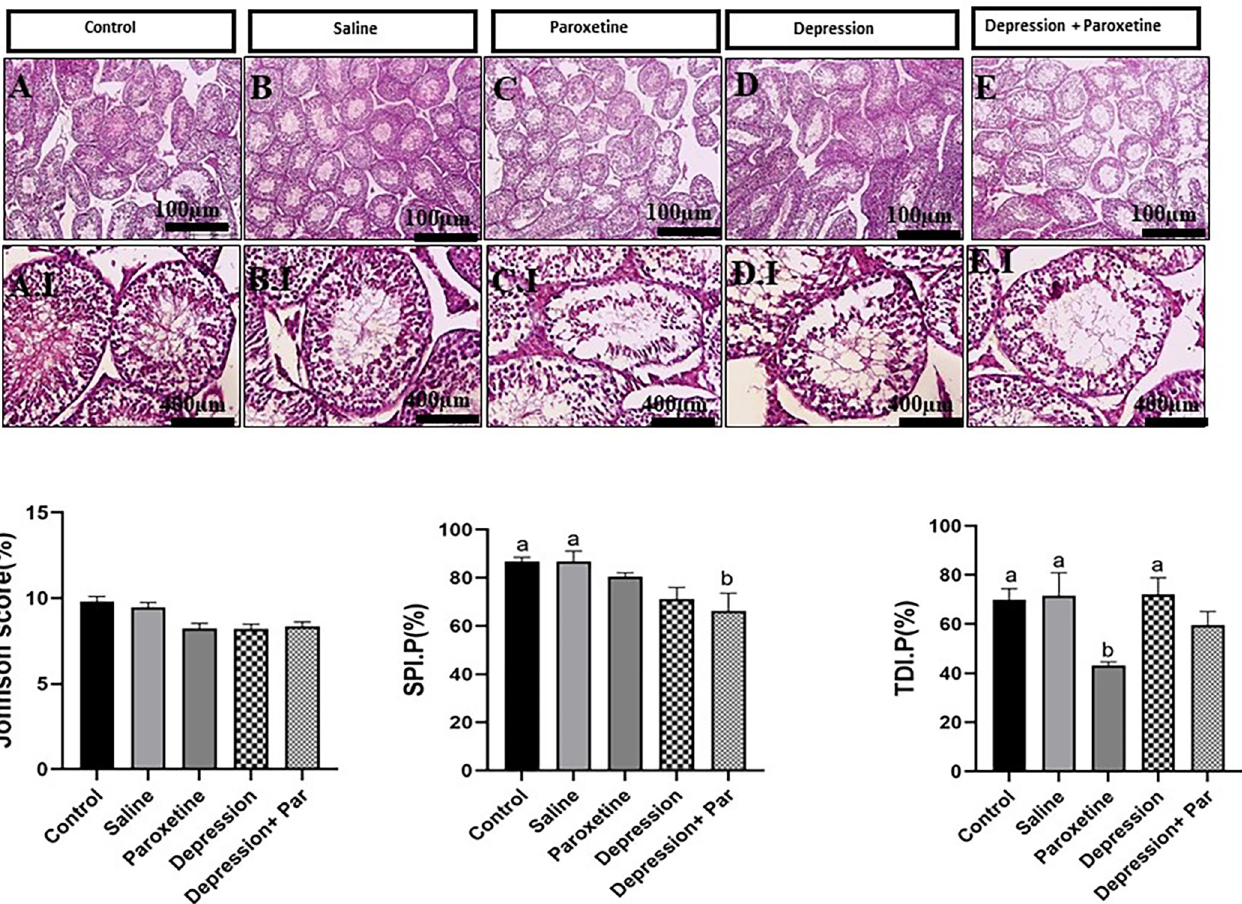
Fig 2. Histological illustration of mouse testicular tissues. Top panels : Comparison of testis sections between groups [A: Control, B: Saline (sham), C: Paroxetine (7 mg/kg), D: Stress (FST), E: Stress + Paroxetine (7 mg/kg)] at two different magnifications (100 μ m: Upper photographs; 400 μ m: Lower photographs). Bottom bar graphs : Comparison of testicular morphometric parameters including percentages of Johnsen score (left), the tubular differentiation index = TDI (middle), and spermatogenic index = SPI (right) between groups. Bars with different superscript letters are significantly different (p < 0.05).